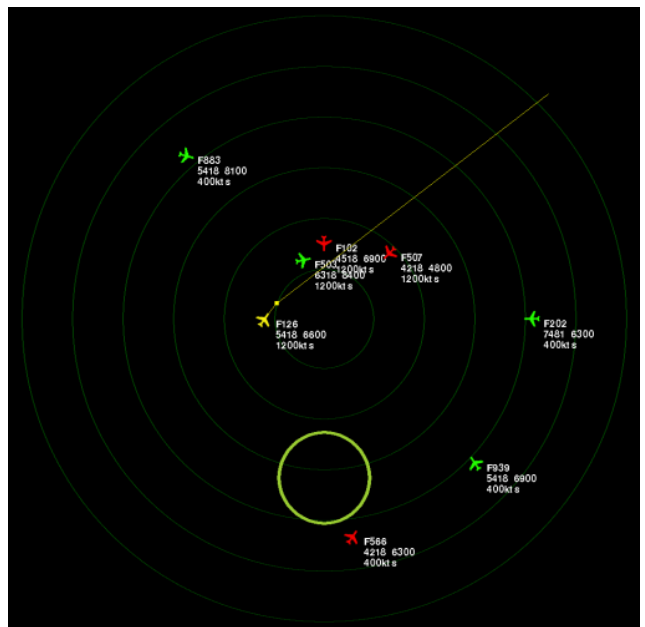
Figure 2. Airspace display area. Aircraft are generated randomly in green. When an aircraft is clicked, it turns yellow and the projected trajectory shows up. The aircraft turns red if it is involved in a conflict. The area covered by the green circle is the danger zone, where aircraft are not allowed to enter.